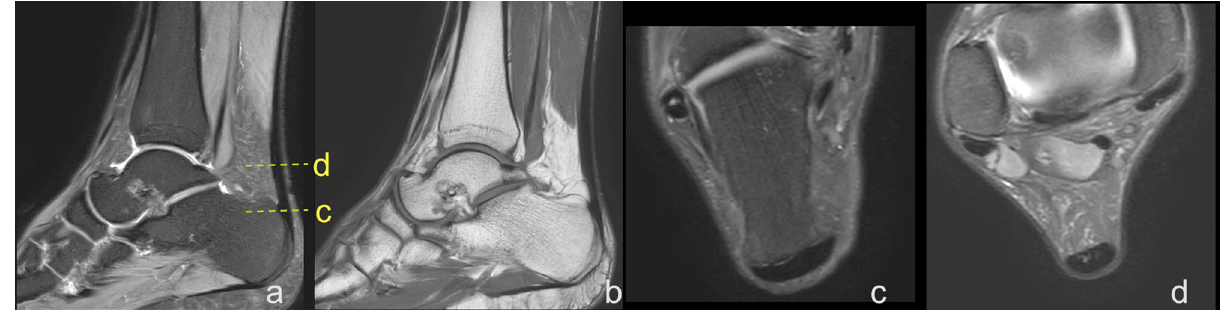
Figure 5. The normal Achilles tendon. A 34-year-old female with clinical suspicion of a nerve tumor on n. tibialis. ( a ) PD- weighted SPAIR, ( b ) T1-weighted, ( c ) and ( d ) PD- weighted TSE SPAIR.